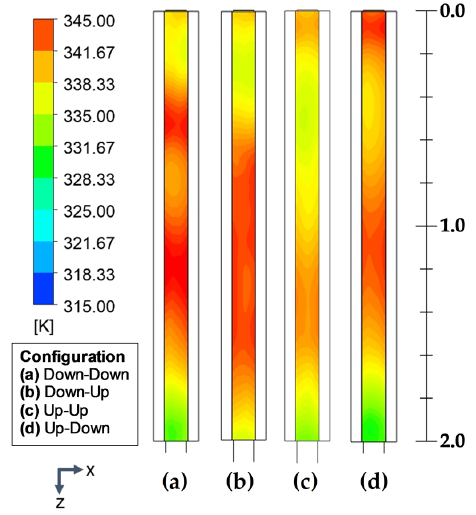
Figure 9. Temperature contours in the flat plate receiver, first pass (Flow 2: 0.02